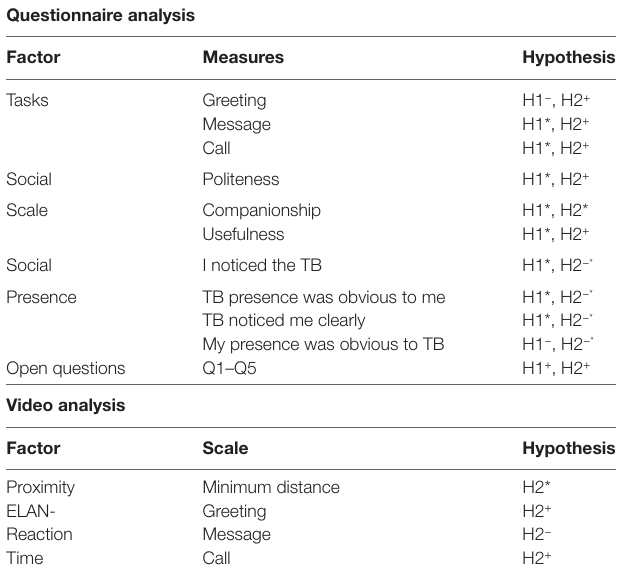
TaBle a3 | Social presence: mobile vs stationary results.